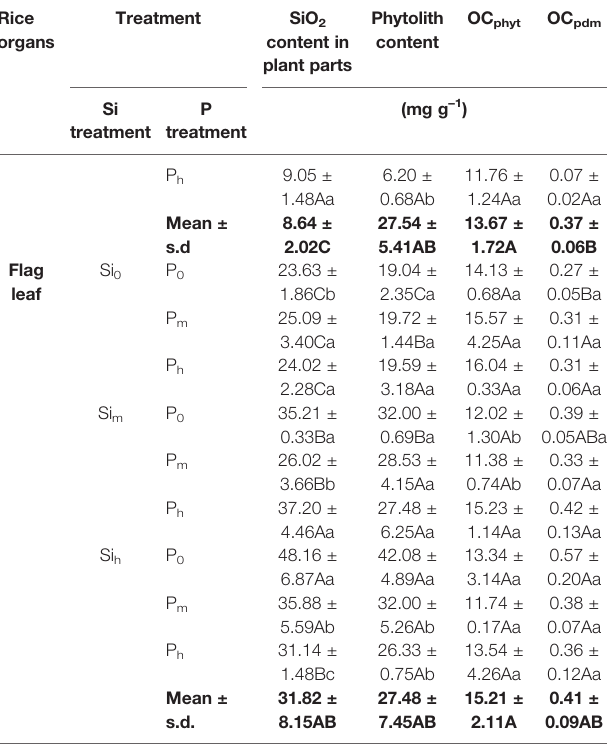
TABLE 6 | Two-way analysis of variance (ANOVA) of silicon-phosphorus (Si-P) levels on the rice shoot biomass, stock of phytolith, and OC pdm in rice shoot.